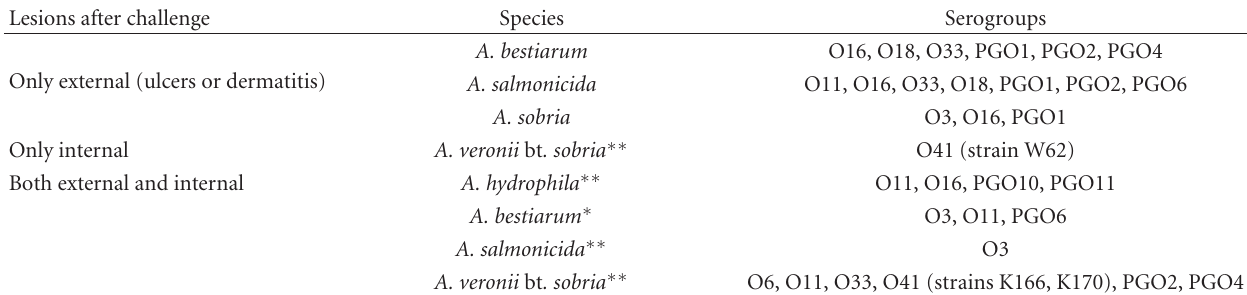
Table 2: Disease symptoms in challenged carp in relation to Aeromonas species and serogroups.